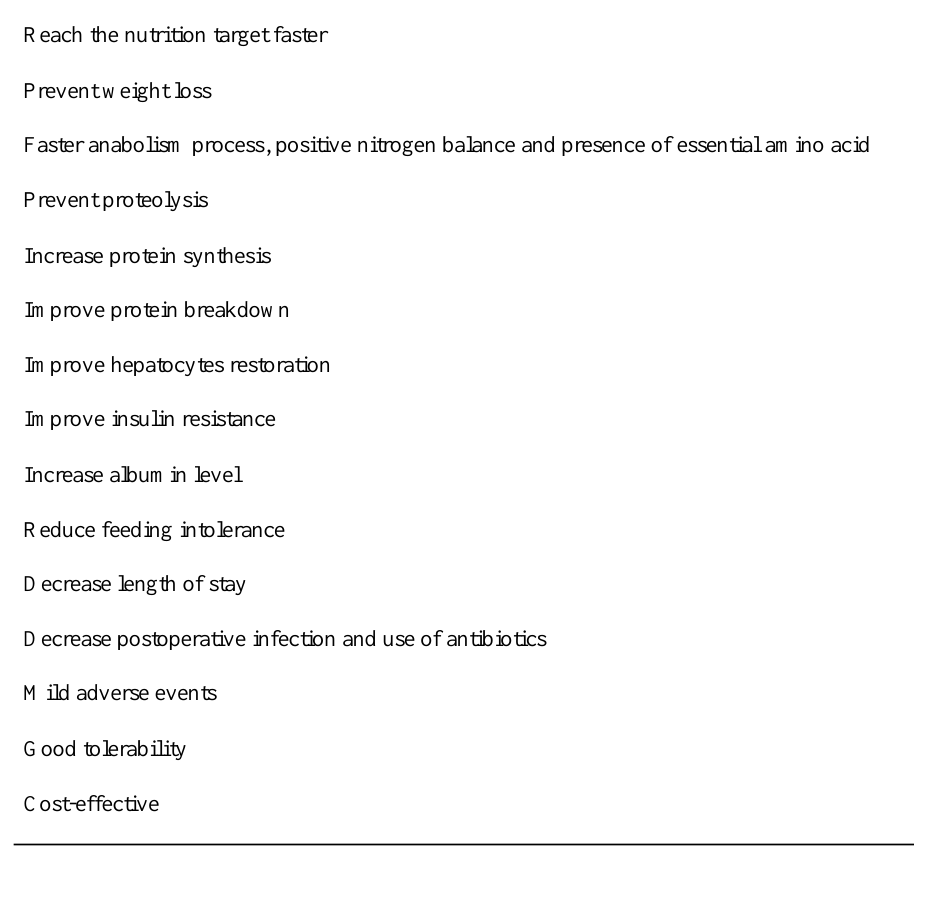
Table 2. Benefits of using nutrient-dense formula for infants with